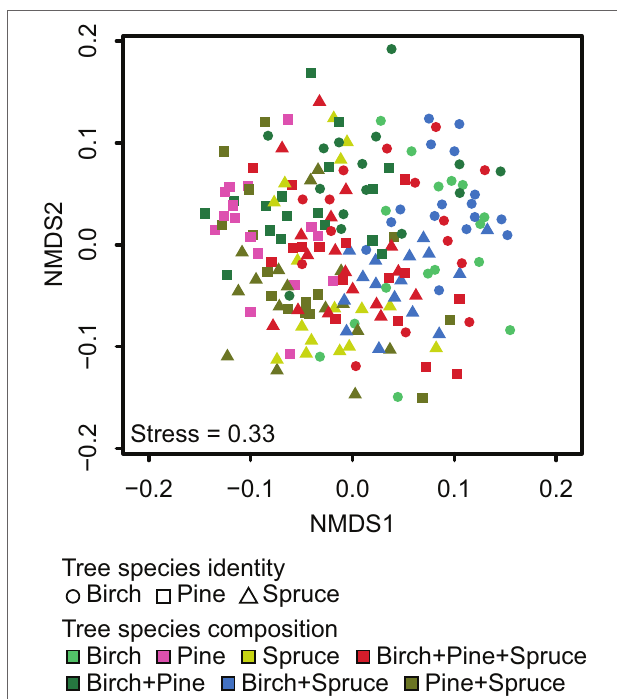
FIGURE 6 | Non-metric multidimensional scaling (NMDS) plots of EcM fungal community composition for tree species identity and tree species